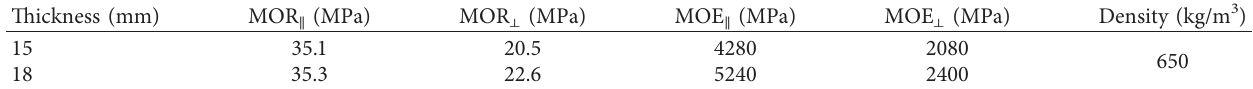
Table 1: Physical and mechanical properties of the adopted oriented strand boards (OSBs). Thickness (mm)